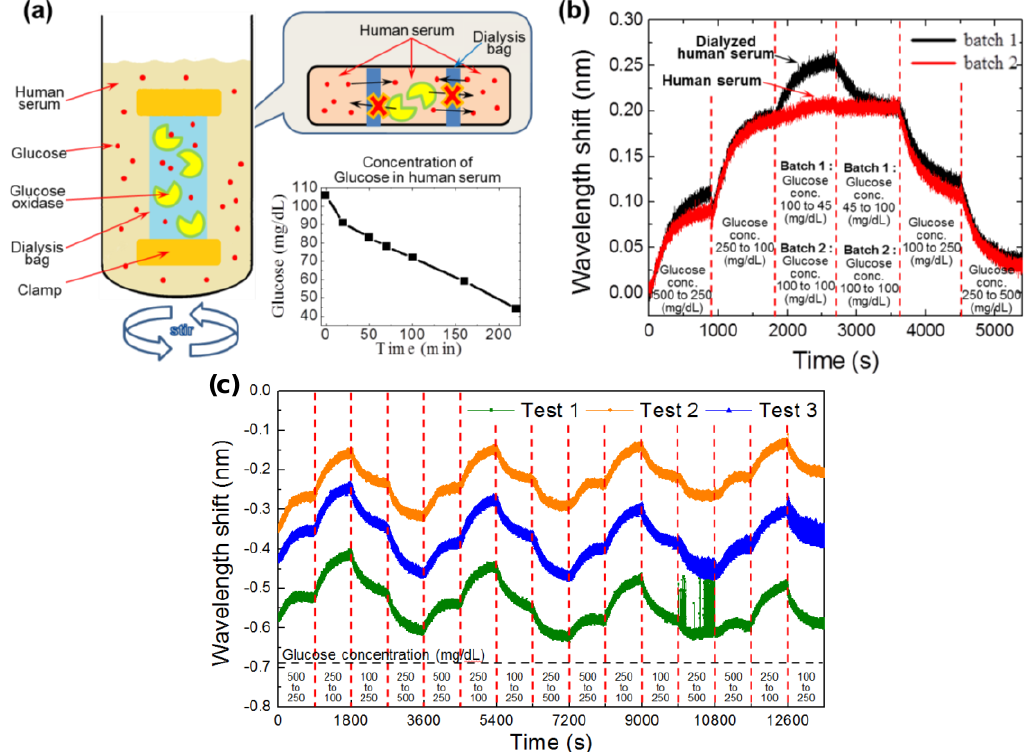
Figure 2. Schematic of the dialysis method and the performance of the sensor for the detection of a broad range of glucose concentrations. ( a ) Schematic of the dialysis procedure. A dialysis bag containing a mixture of glucose oxidase and human serum was used. This dialysis bag was kept in the container of human serum to reduce the glucose concentration of the serum. The time vs. glucose concentration is the glucose attrition of the serum measured with a standard strip sensor; ( b ) Performance of the needle-type sensor. The sensor shows a peak at 1800 s for the batch 1 samples (dialyzed human serum: 45 mL/dL, 100 mL/dL, 250 mL/dL, and 500 mL/dL), which have glucose concentrations comparable to that observed in hypoglycemia, whereas this peak is not observed in the profile for batch 2 (normal human serum: 100 mL/dL, 250 mL/dL, and 500 mL/dL). Averaged standard deviation for a constant glucose concentration (i.e., 100 mg/dL and t = 1800–3600 s of batch 2) was measured as 0.005496 nm, corresponding to 2.77% of the wavelength shift; ( c ) Repeatability test results ( n = 3) for glucose concentration range of 100–500 mg/dL.